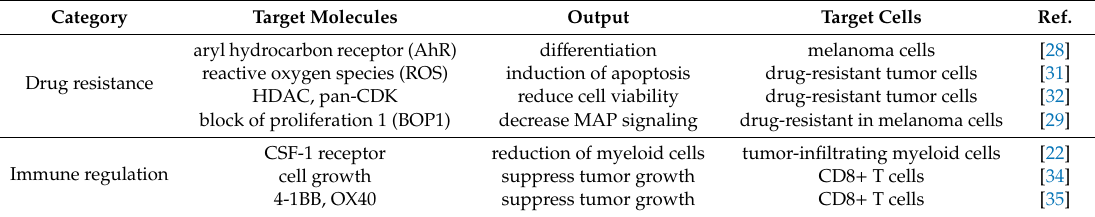
Table 2. Pre-clinical trials for BRAF-mutant